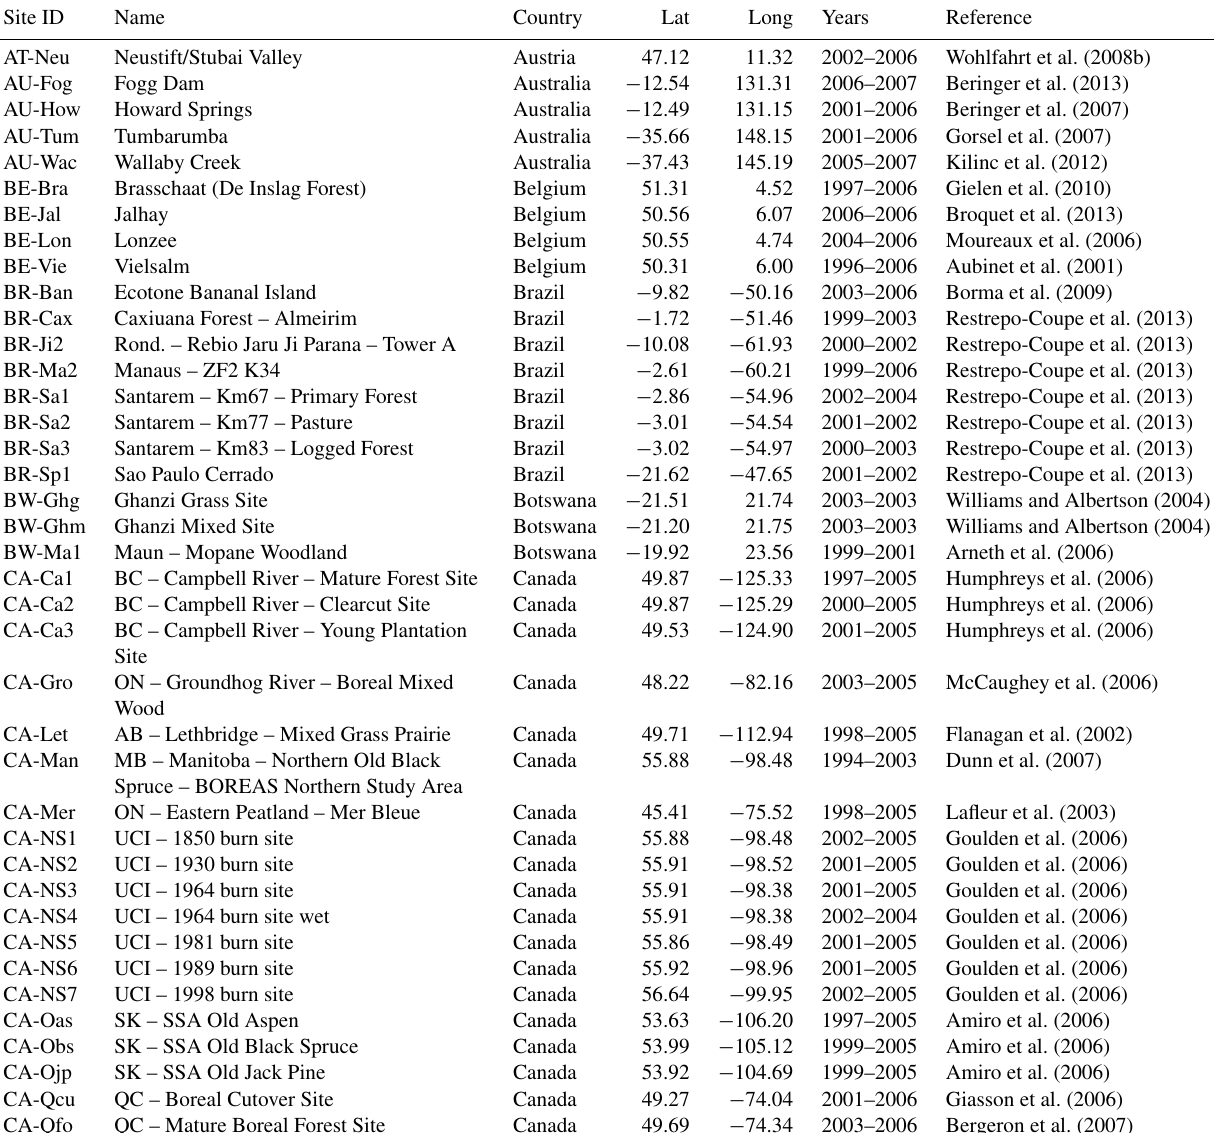
Table D1. This is a list of 222 FLUXNET sites from which we have used data in our